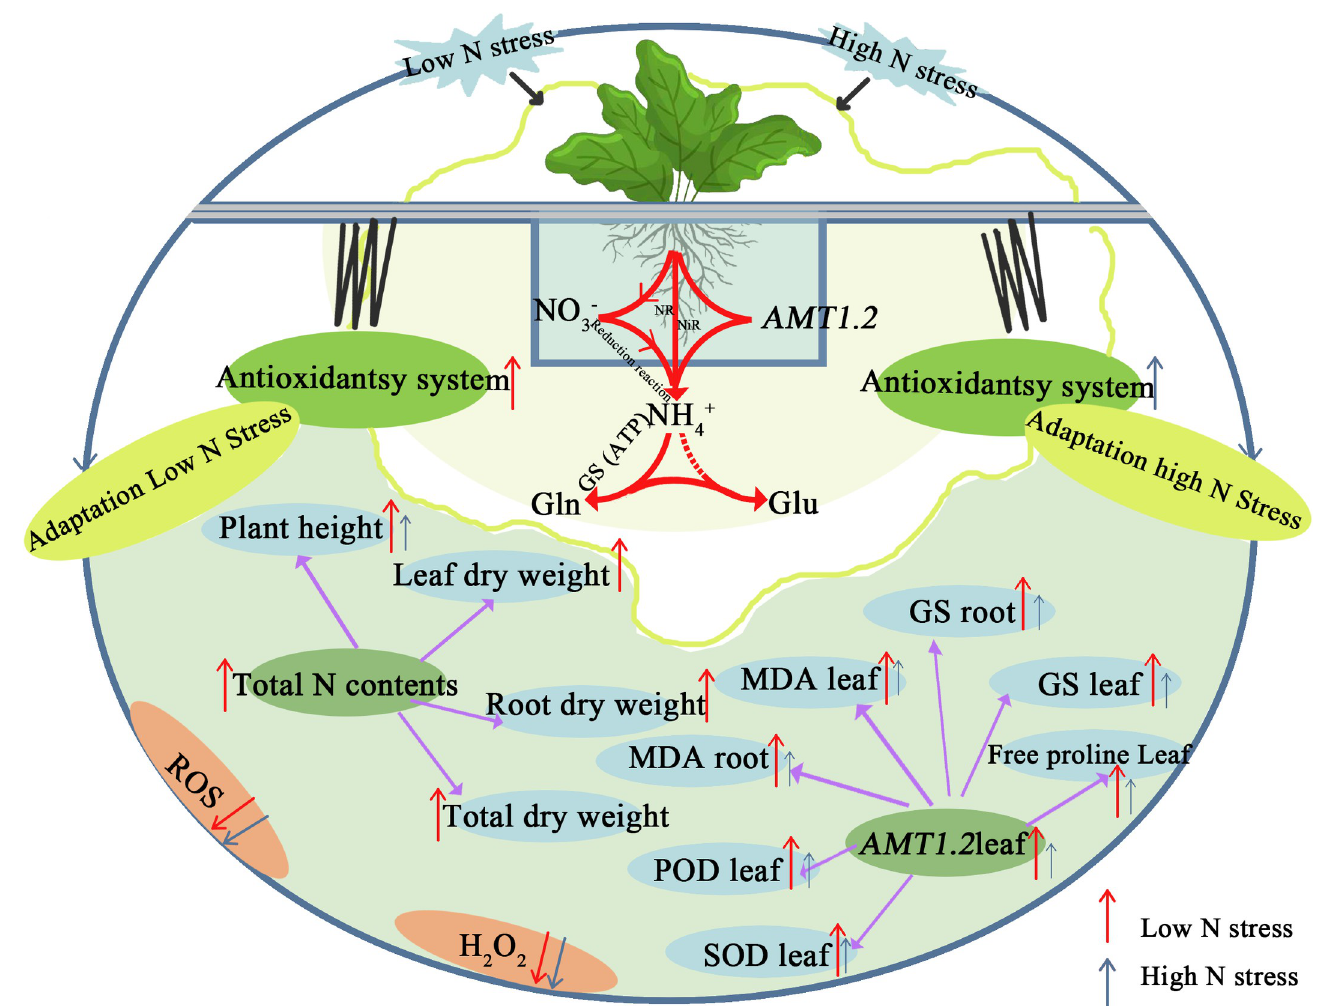
Fig 6. Schematic model of stress growth of sugar beet seedlings under low and high nitrogen conditions.